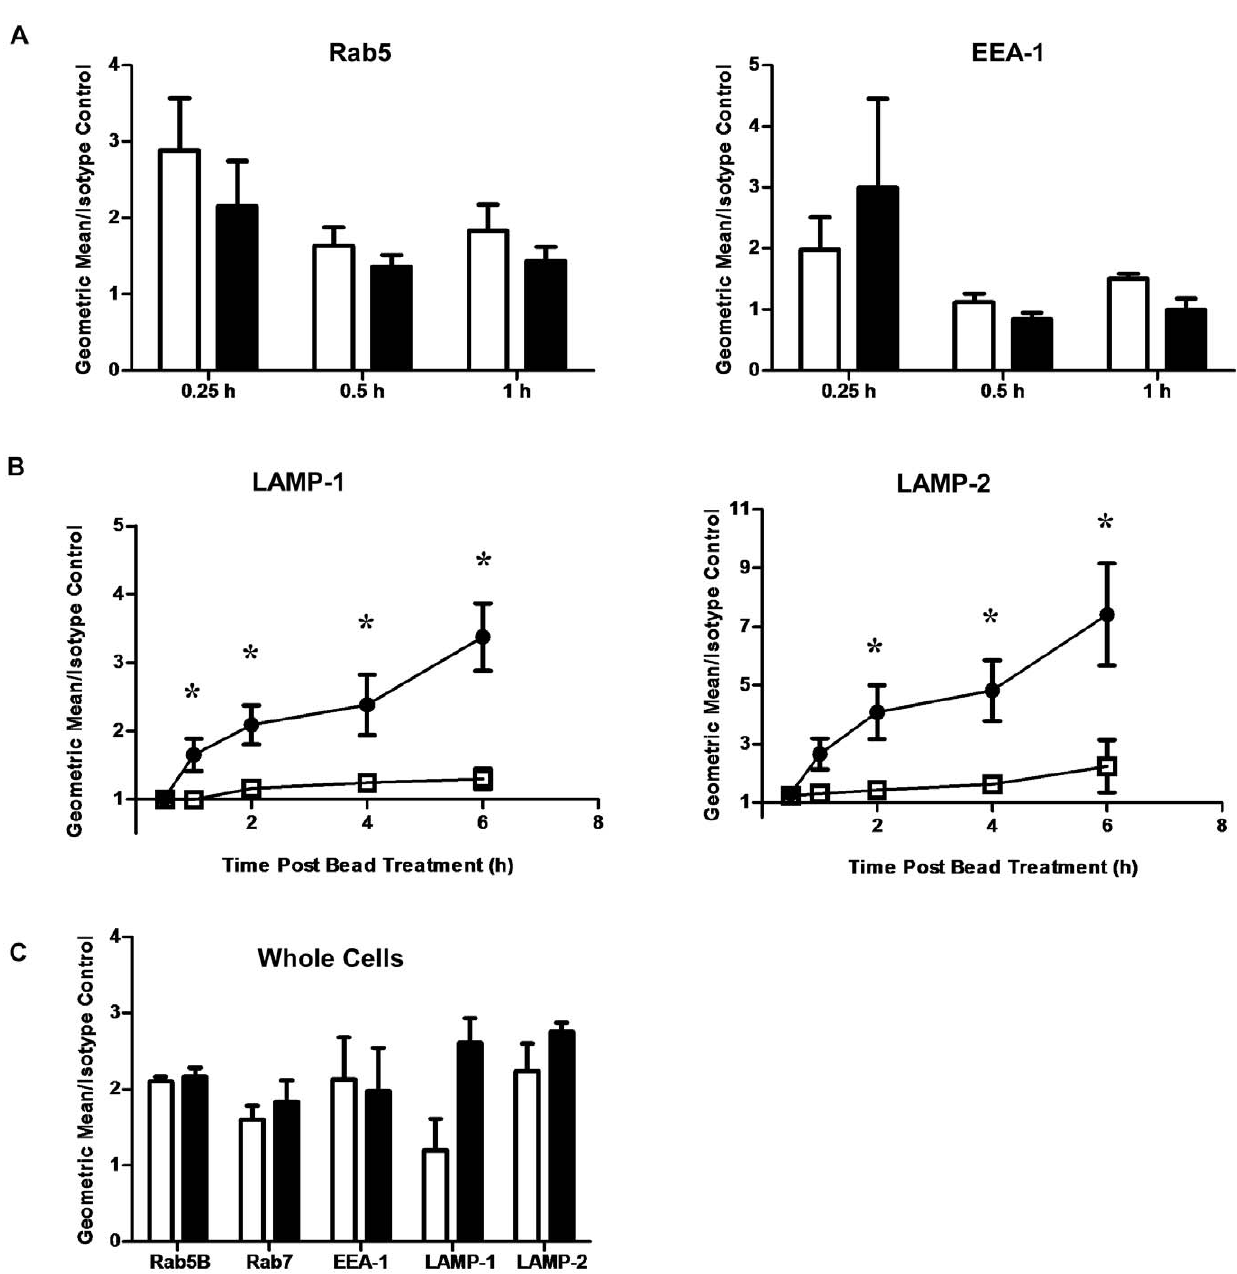
Figure 3. Magnetic bead phagosomes from p110 a knockdown cells show defective acquisition of the lysosomal proteins LAMP-1 and LAMP-2. Kinetic analysis of phagosome maturation by flow organellometry shows A) normal acquisition of the early endosomal marker Rab5 and EEA-1, and B) marked defects in the acquisition of the lysosomal membrane proteins LAMP-1 and LAMP-2 by p110 a knockdown cells. Solid circles = control cells, empty squares = p110 a knockdown cells. Timepoints were taken at 30 minutes, 1 hour, 2 hours, 4 hours, and 6 hours post bead treatment. Data are means + / 2 s.e.m., from five independent experiments. Ratios of geometric mean over isotype control of 1 or less are interpreted as negligible signal. *p , 0.05. C) Whole cell expression of phagosome markers are at similar levels in control and p110 a knockdown cells. Staining of permeabilized cells and flow cytometric analysis of various phagosome markers in control and p110 a knockdown cells showed no significant differences in cellular levels. Empty bars = control cells, solid bars = p110 a knockdown cells. Data are means + / 2 s.e.m., from three independent experiments. doi:10.1371/journal.pone.0043668.g003 GEFs (guanine nucleotide exchange factors). Upon spontaneous deficient cells. This was done by examining the ability of phagosome associated Rab7 to recruit its downstream effectors, dissociation of a Rab GDI (GDP dissociation inhibitor) from a Rab protein, Rab-GTP is generated which then inserts into the RILP, and the HOPS (homotypic vacuole fusion and protein membrane [28]. In light of this model, we sought to determine sorting) complex to phagocytic vacuoles. RILP binds to GTP- the activation state of the Rab7 found on phagosomes from p110 a bound Rab7 and recruits dynein-dynactin motor complexes which